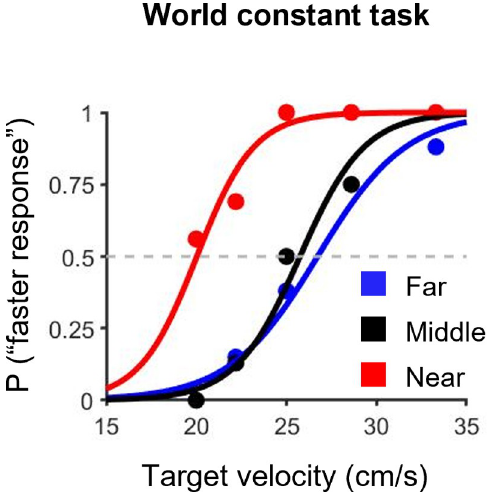
Fig 4. A typical example of psychometric functions for the world constant task. Colors indicate the three different initial positions of the target from the participants: blue, black and red lines are the far, middle and near conditions,